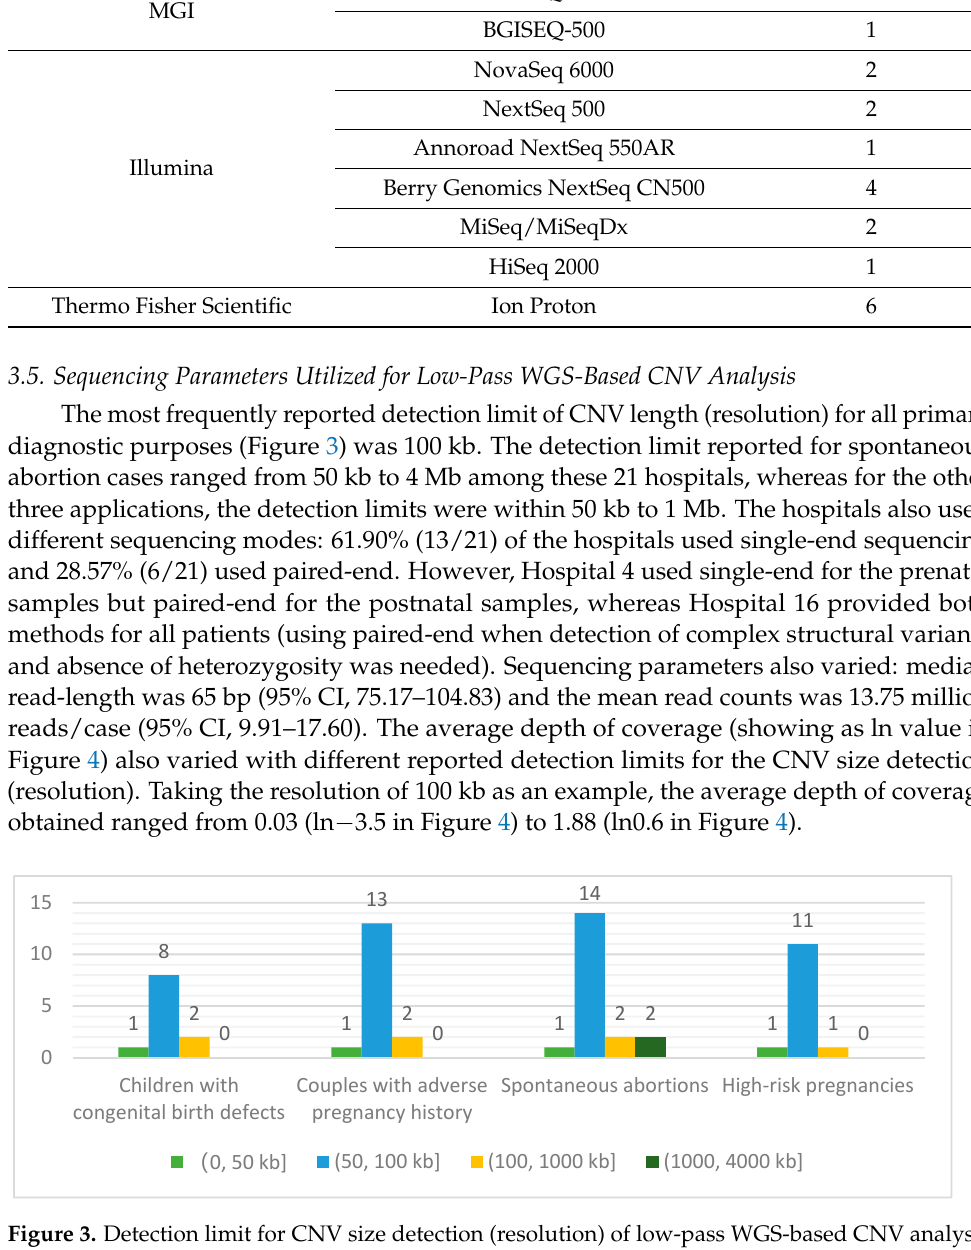
Figure 4. Sequencing parameters used by 21 Chinese tertiary hospitals in this survey. The average depth of coverage (ln value) varied across different reported detection limits for CNV size detec- tion (resolution). Taking the resolution of 100 kb as an example, the average depth of coverage ranged from 0.03 (ln − 3.5 in the figure) to 1.88 (ln0.6 in the figure). 3.6. The Compliance of CNV Reporting Nomenclature with Internationally-Recognized Criteria In total, 19 participants submitted the reporting nomenclatures for DGS (deletion type of CNV) and CMT1A (duplication type of CNV) based on their routine practice with low-pass WGS-based CNV analysis (Table 3). Twelve types of nomenclature were re- ceived for both DGS and CMT1A, and the nomenclature of DGS and CMT1A submitted by the same participant followed the same reporting format. The scoring criteria were designed to verify whether each submitted nomenclature was compliant with the inter- nationally recognized criteria: 5 points were awarded for following the ISCN 2016 nomen- clature format for chromosomal aberrations; 5 points were awarded for following the HGVS nomenclature format for nucleotide variants; and a deduction of 1 point was made if (1) the symbol of sequencing-based technology was not mentioned in the string; (2) the genome build was not included; (3) the prefix reference sequence “g.” was not present; (4) the affected chromosome was not listed for the ISCN-like or HGVS-like portions; (5) the affected chromosome arm and band were not given; (6) “del” or “dup” was not used to describe the variant type; (7) the span of nucleotides was not provided; or (8) other errors